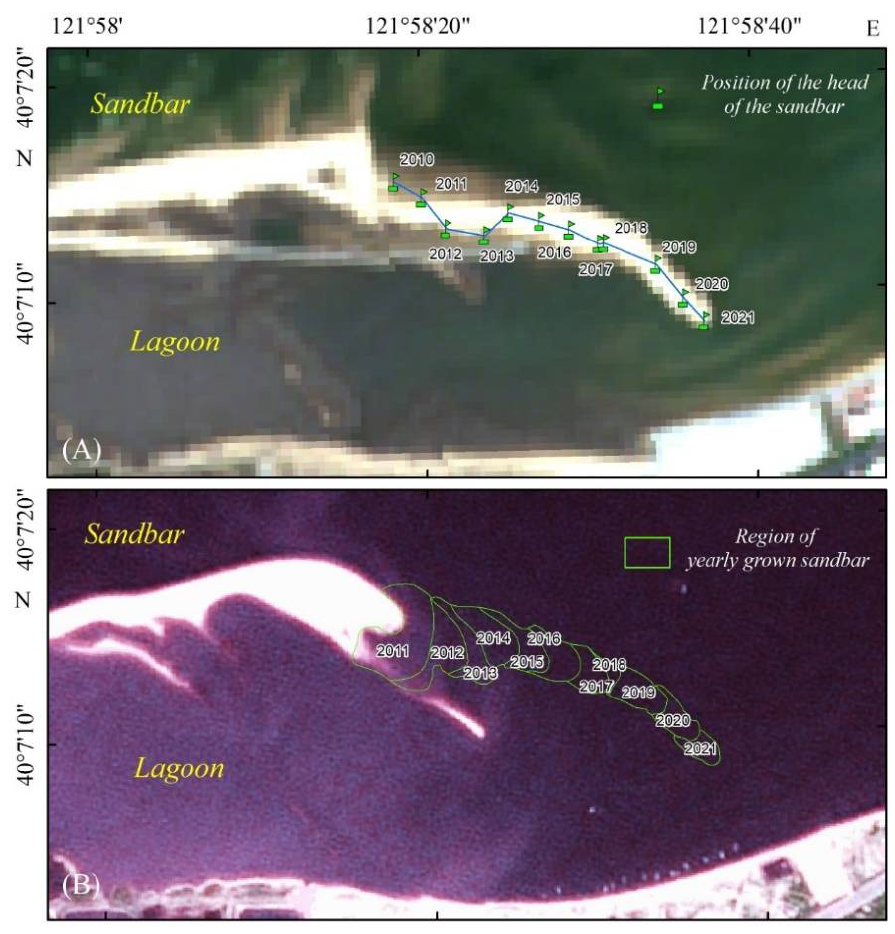
Figure 4. Lateral Evolution of the FESL. ( A ) Head position of the sandbar, base map is the remote sensing image in 2021; ( B ) Yearly growth region of the sandbar, base map is the remote sensing image in 2010.